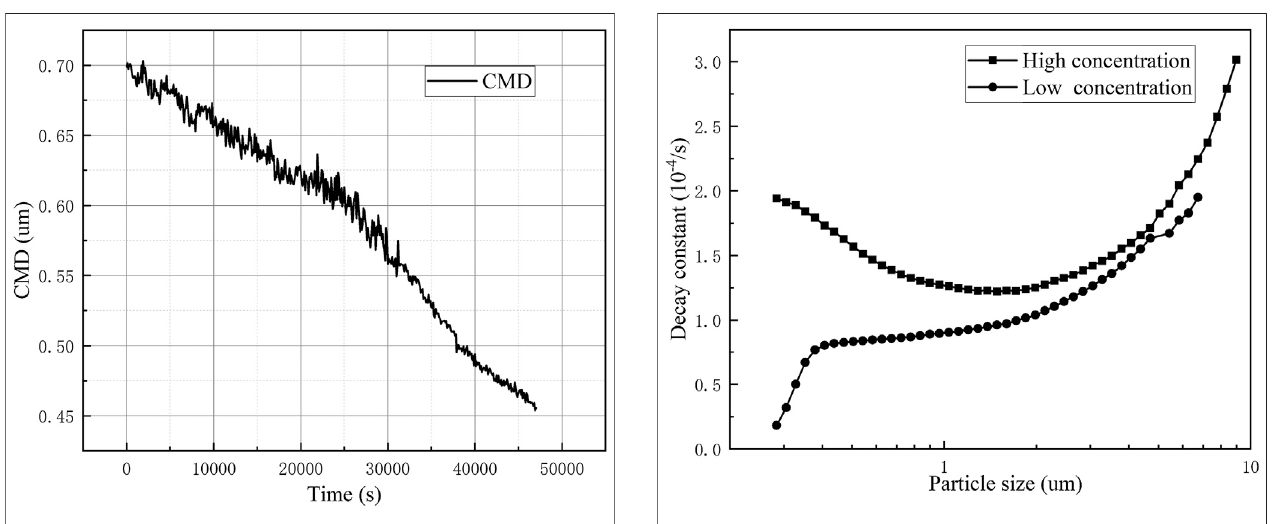
FIGURE 7 | CMD changes with time. CMD changes with time at lower concentrations.